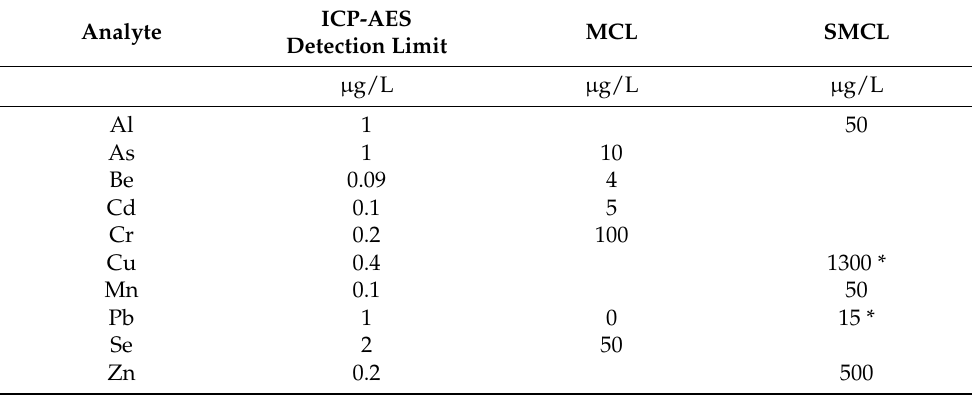
Table 2. Heavy metal analysis–detection limits of ICP-AES and either the United States Environ- mental Protection Agency (USEPA) maximum contaminant level (MCL) or secondary maximum contaminant level (SMCL) for each metal [65]. ICP-AES MCL SMCL Analyte Detection Limit µ g/L µ g/L µ